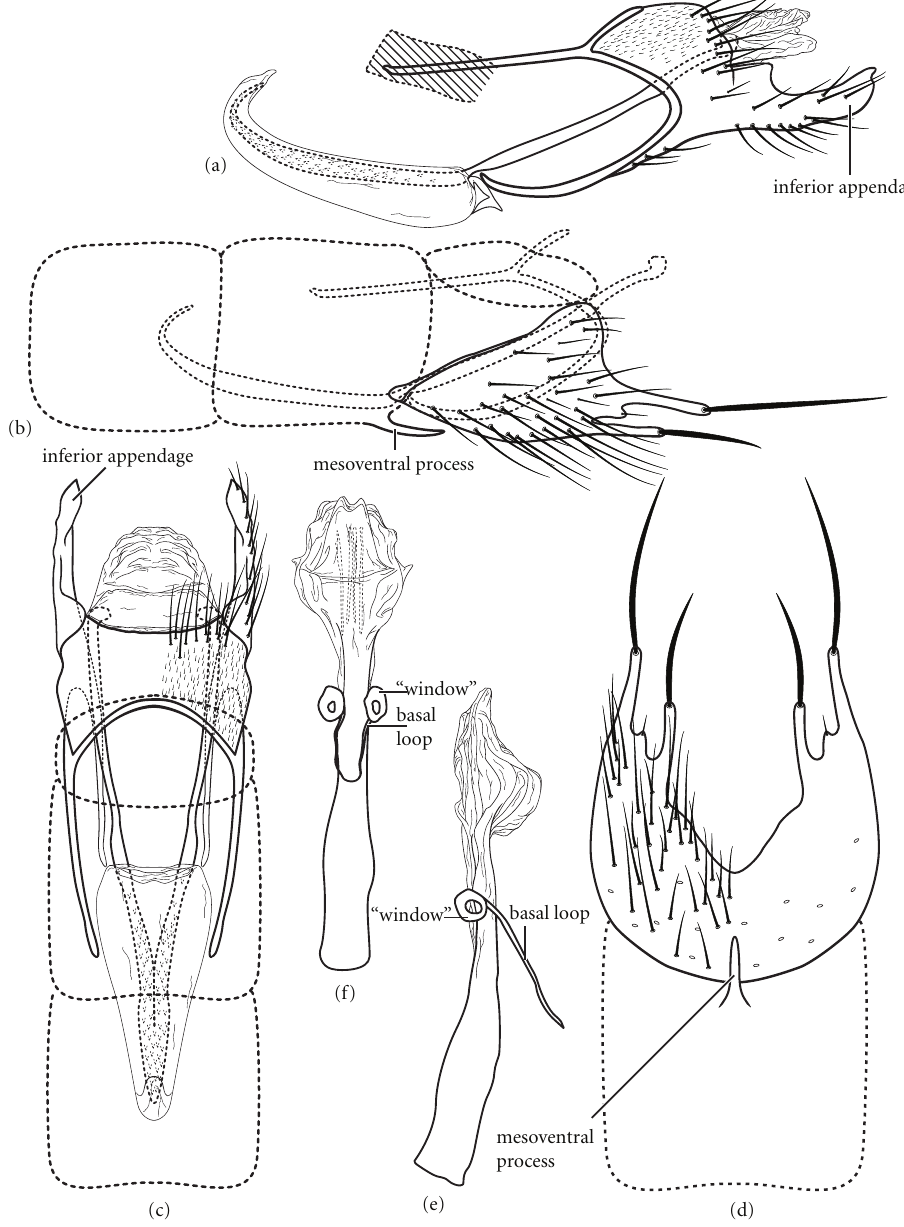
Figure 1: Betrichia alibrachia sp.n., male genitalia: (a) segments IX-X, left lateral (base of phallus crosshatched); (b) segments VI–VIII and segment IX anterolateral margin, left lateral; (c) segments VI–X, dorsal; (d) segments VII-VIII, ventral; (e) phallus, left lateral; (f) phallus,